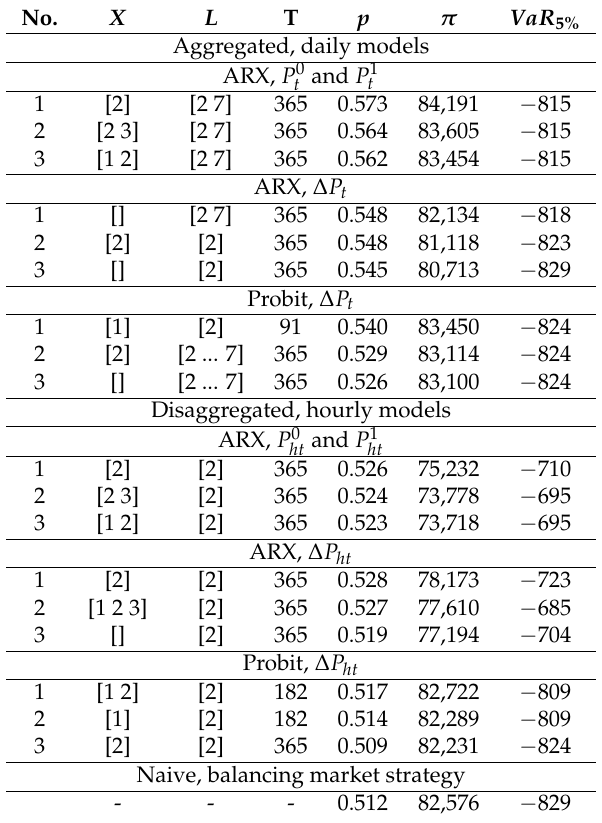
Table 4. The comparison of profits and risks for Polish data. Note that the results for only the top three, best-performing model specifications in terms of total yearly profit π , relative to the day-ahead strategy, are reported in each